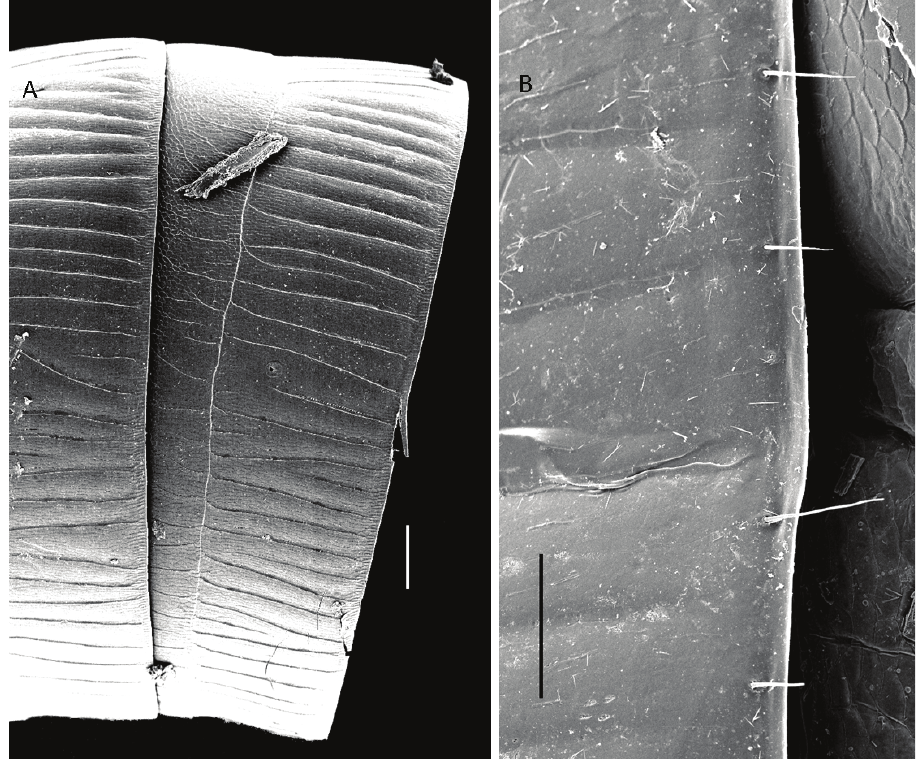
Fig. 2. A . D. typhlocanaria sp. nov., male from Cueva de la Luna, midbody rings. Scale 0.1 mm. B . D. oromii sp. nov., detail of posterior margin of midbody ring, showing diagnostic setae. Scale 0.05